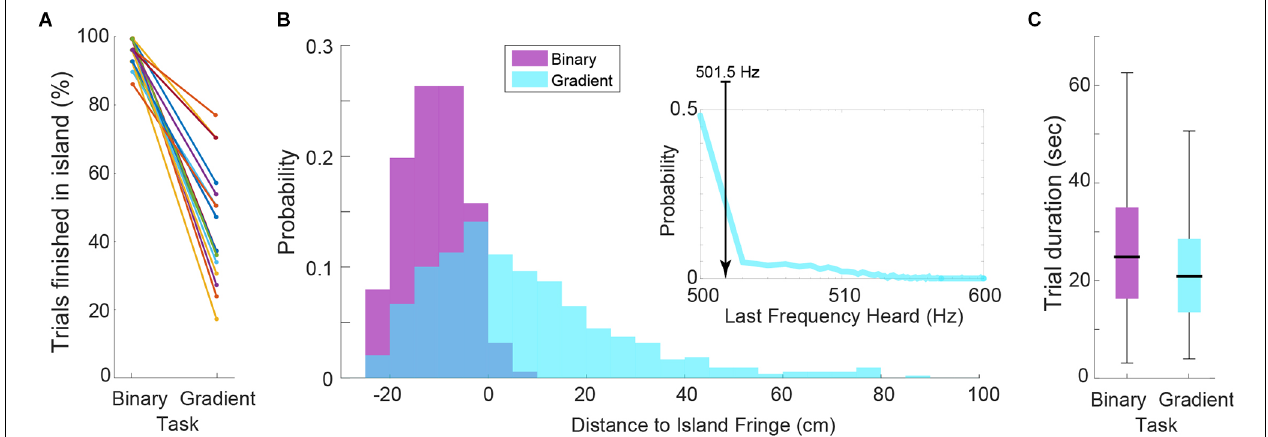
FIGURE 2 | (A) Percentage of trials finished within the target island. Each line represents a subject. Note that while this measure is equal to performance in the binary task, it is not for the gradient task. (B) Histograms of the distance to island fringe for all trials across subjects for both task versions. Inset: Histogram of last frequency heard when subjects finished the gradient trials. Median of 501.5 Hz is shown. (C) Distributions of trial durations by task ( P =